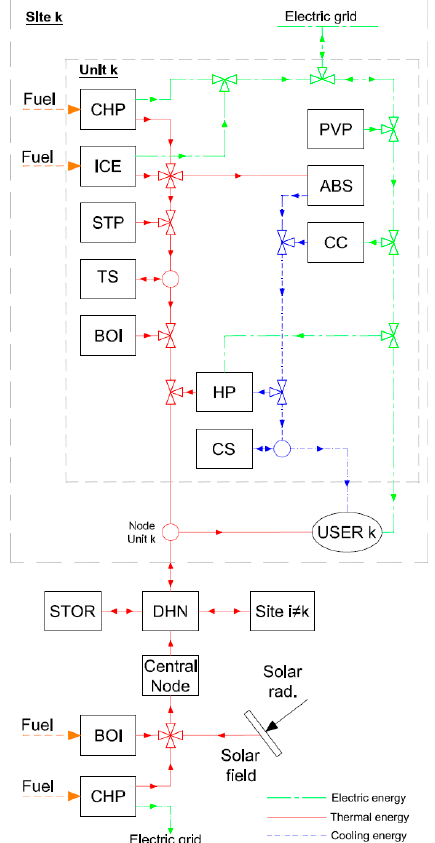
Figure 1. Superstructure of the distributed generation solution (integrated with central solar system).